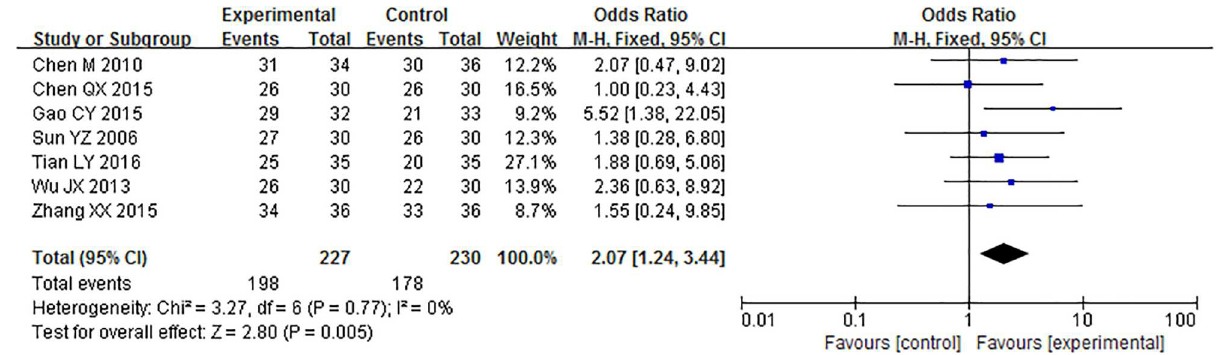
Fig 6. Meta-analysis of the clinical effective rate.